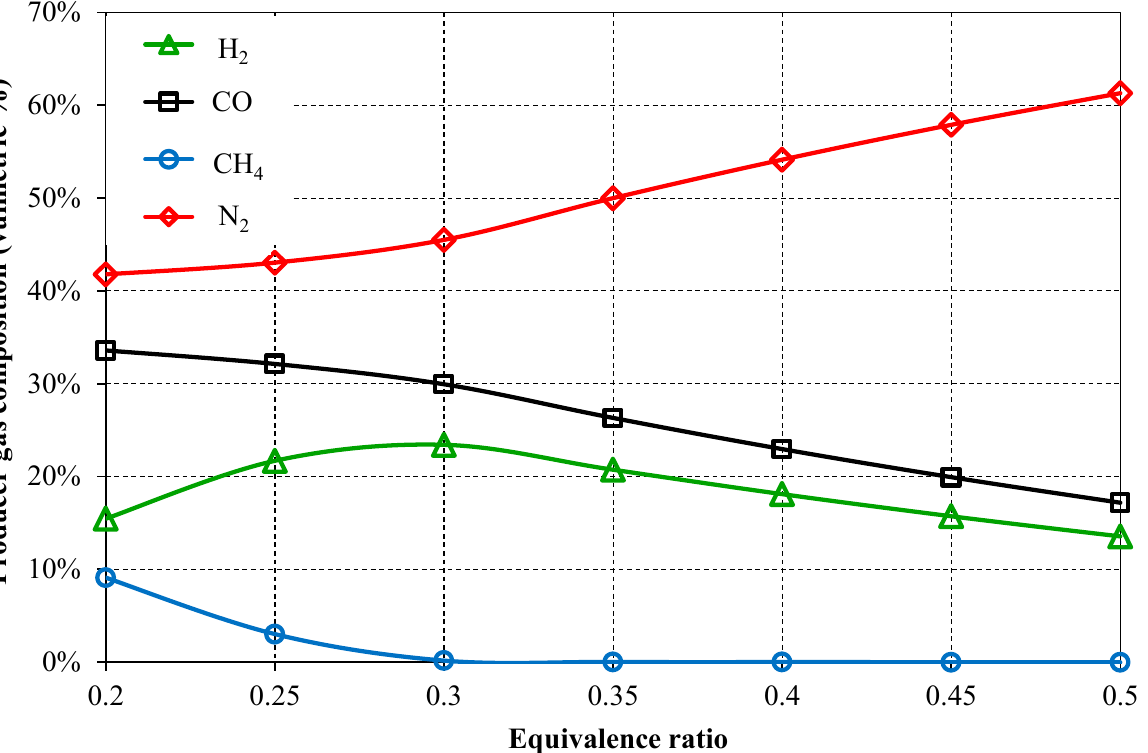
Figure 5. Effect of ER on the composition for oxygen gasification. 3.2. Producer Gas LHV Regarding producer gas LHV, a decreasing trend was observed as ER increased until reaching values that oscillate in the range of 6.37 and 3.63 MJ/Nm 3 for ER values greater than 0.30 when using air as the gasification agent (see Figure 6). This behavior is associated with a higher amount of gasification agent supplied, which favors the reforming and thermal cracking reactions of the heavier organic fractions contained in